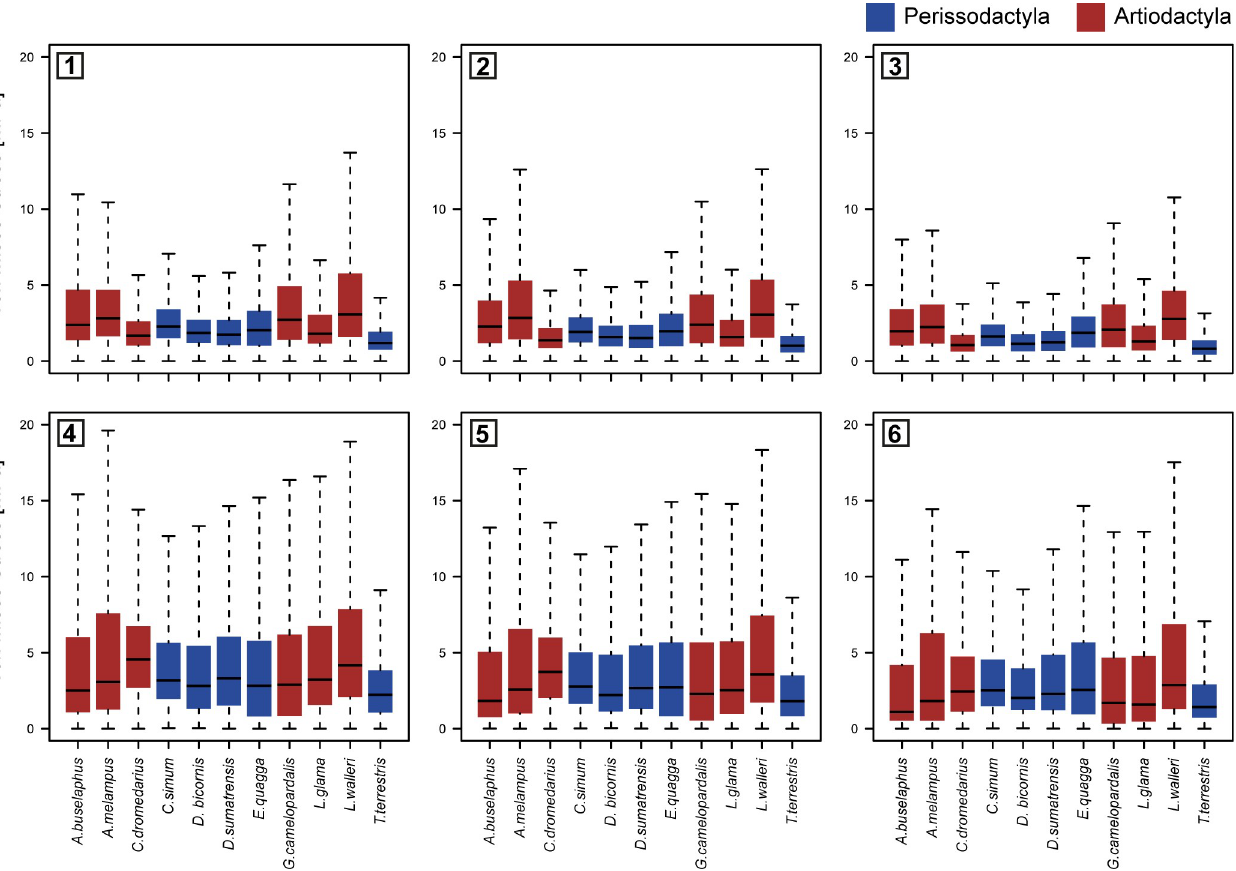
Fig 3. Box-plots of modelled von mises stress distributions in the mandible by taxon for each bite configuration and bite position. Lateral cases 1) in M1 2) in M2 and 3) in M3. Orthal cases 4) in M1 5). In molar M2 and 6) in M3. Quasi-Ideal Mesh (QIM) was assumed. Upper and lower whiskers indicate 90% thresholds of the von Mises stress